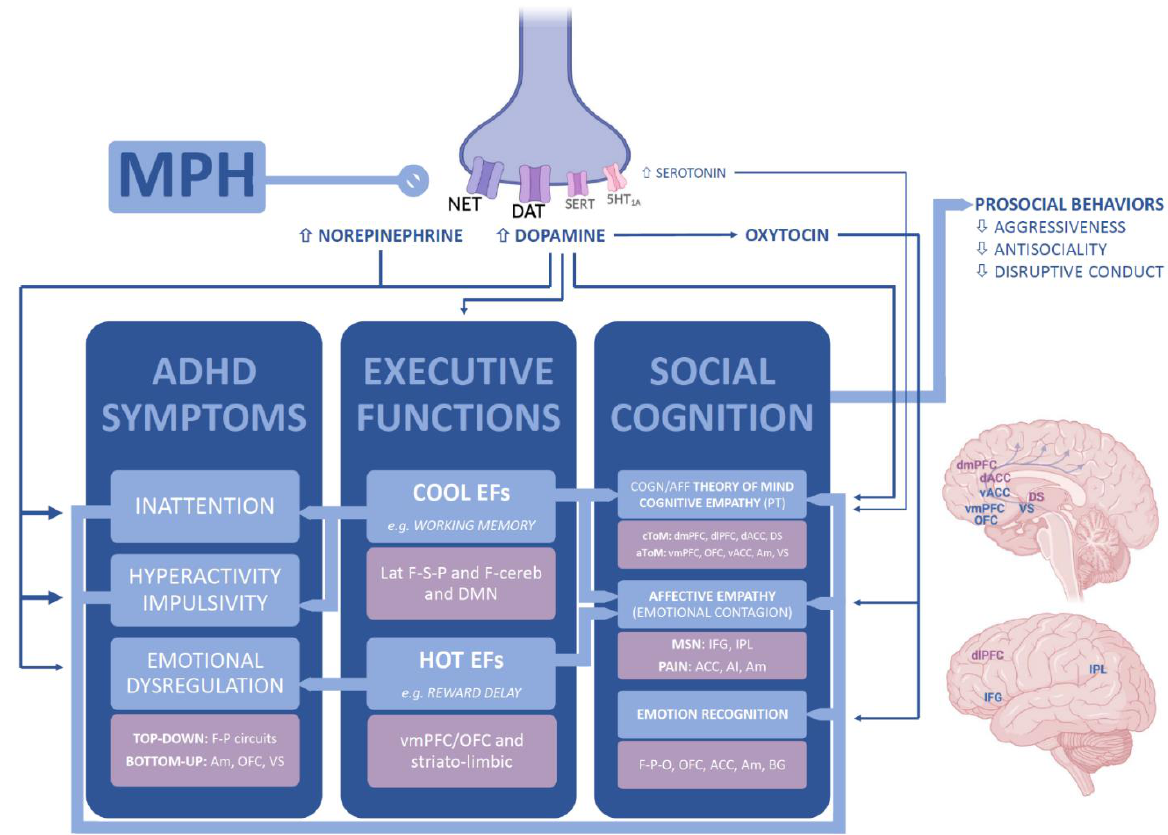
Figure 2. Proposed neurobiological pathways linking methylphenidate pharmacodynamic effects and changes in social cognition in patients with ADHD.